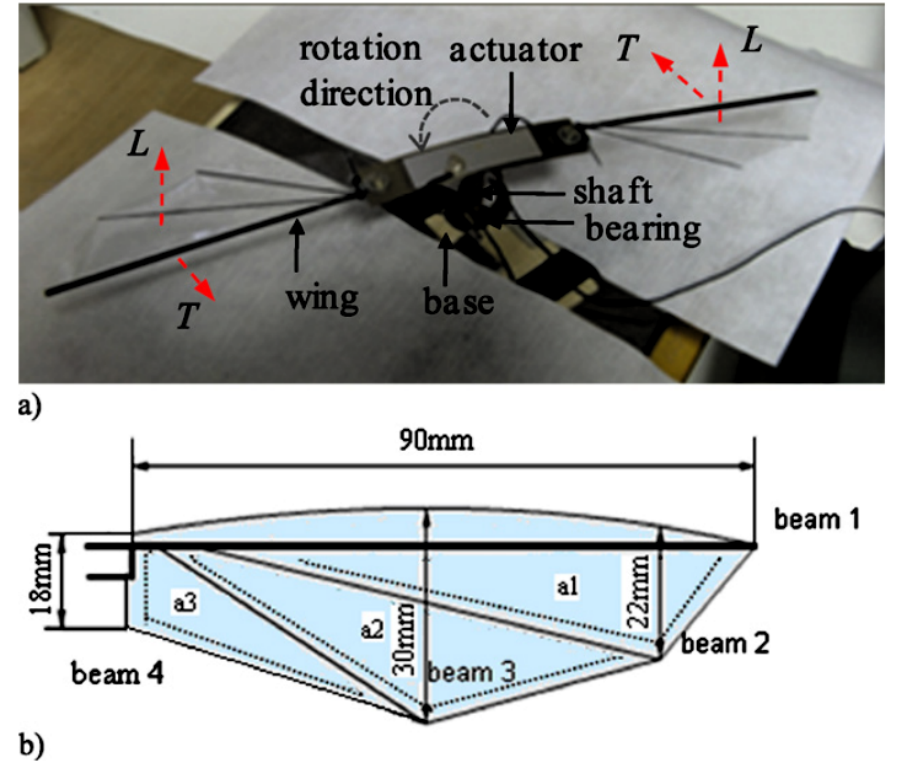
Figure 8. ( a ) The proposed configuration; ( b ) Geometric dimensions of the flapping wing